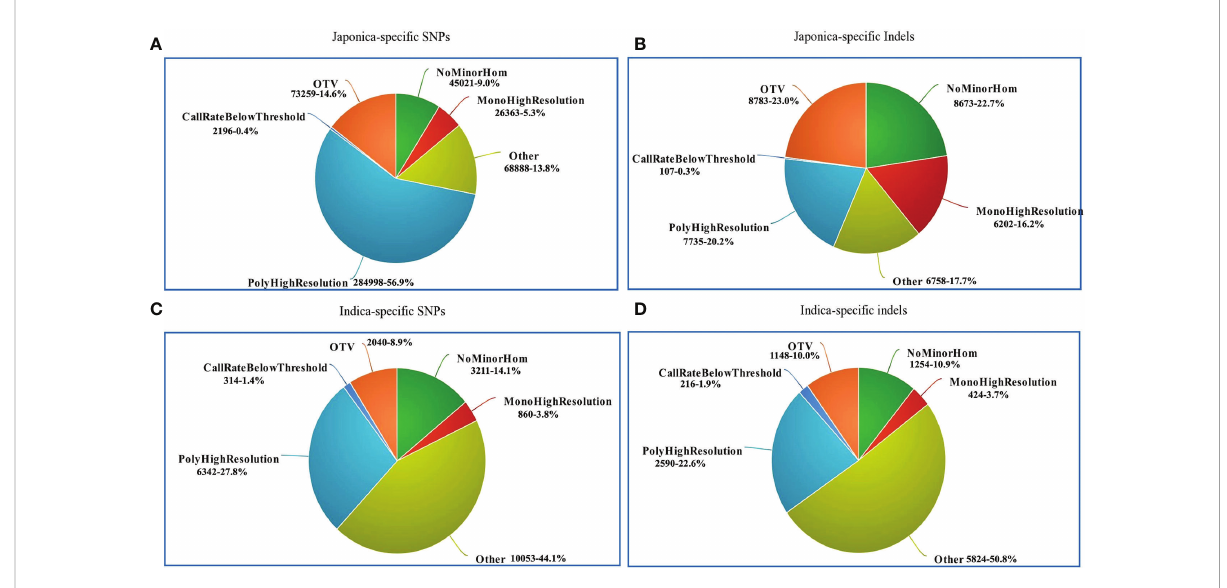
FIGURE 5 Summary of SNP genotyping data in 4720 accessions using the 580K _ KNU chip. (A) Classi fi cation of japonica-speci fi c SNPs (B) Classi fi cation of japonica-speci fi c indels (C) Classi fi cation of indica-speci fi c SNPs (D) Classi fi cation of indica-speci fi c indels. NoMinorHom: No minor homozygote, MonoHighResolution: Monomorphic high-resolution, PolyHighResolution: Polymorphic high-resolution, CallRateBelowThreshold: Call rate below threshold, OTV: Off-target